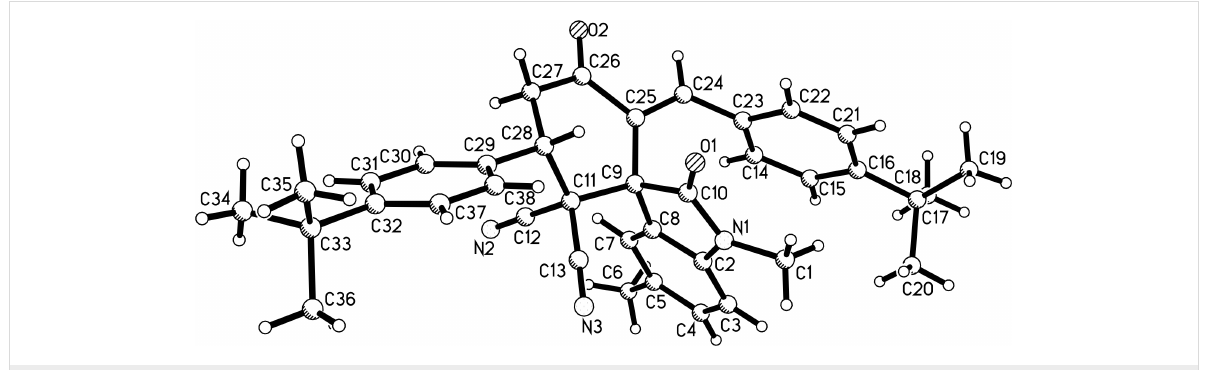
Figure 3: Single crystal structure of compound 3f’ .